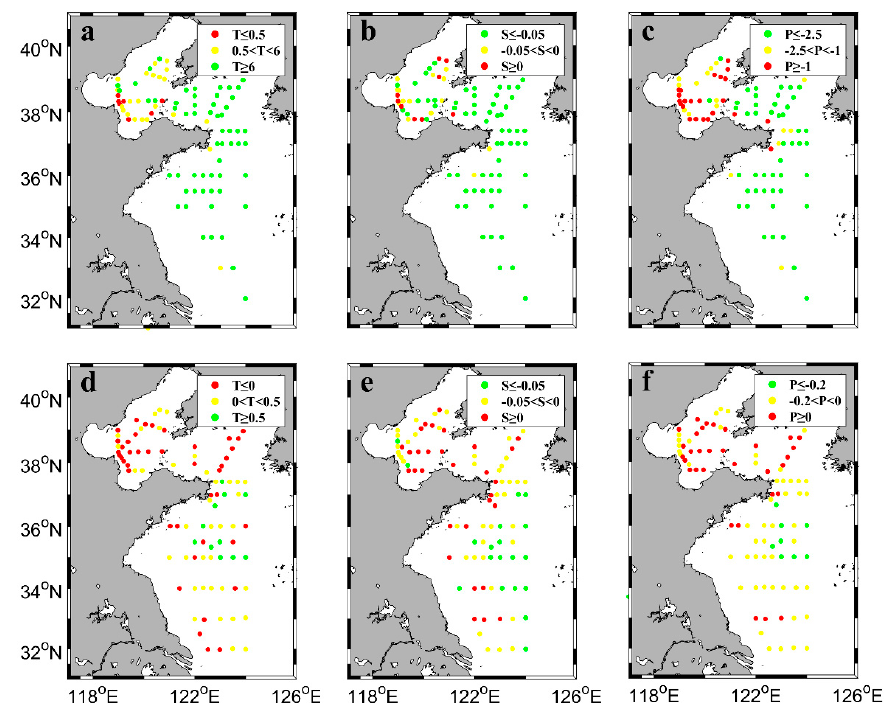
Figure 2. Spatial distributions of the normalized di ff erences (di ff erence values between the surface and bottom) of surface and bottom hydrological features, including the temperature (T, unit: ◦ C), the salinity (S, unit: psu), and the density (P, unit: kg / m3); ( a – c ) show summer measurements, and ( d – f ) show winter